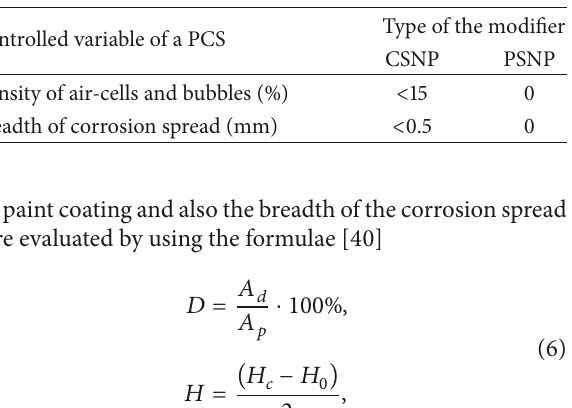
Table 1: Comparative corrosion resistance of modified PCSs to salt